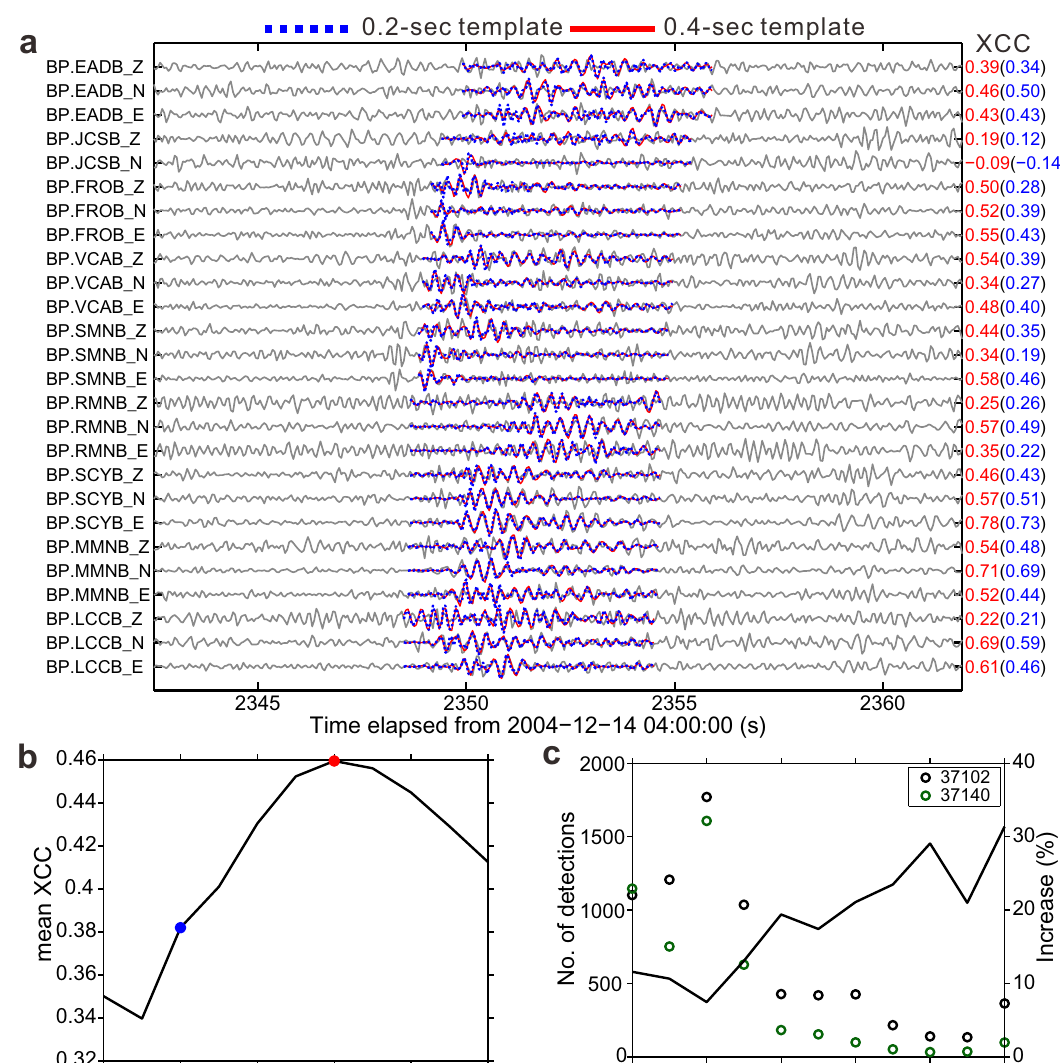
Fig. 3 | Detection and duration classi fi cation of low-frequency earthquakes. a Example of detection and duration classi fi cation of a low-frequency earth- quake. Its duration is assigned to be 0.4s. The blue and red waveforms are original and synthetic templates, with a duration of 0.2 and 0.4s, respectively. The station codes and channels (E: BP2/SP2; N: BP3/SP3; Z: BP1/SP1) are labeled on the left while the individual cross-correlation coef fi cients (XCCs) between